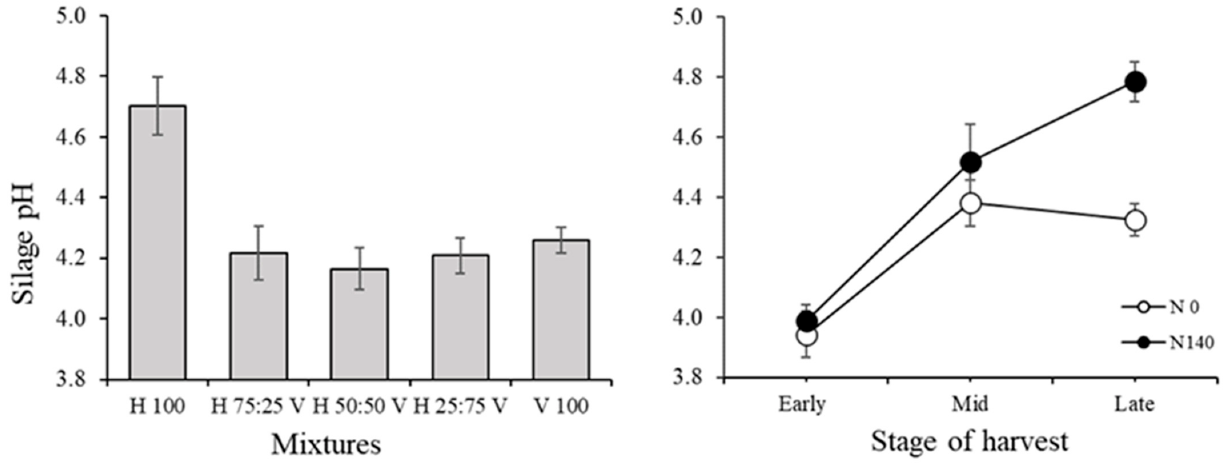
Figure 8. Silage pH as affected by MX ( left ) mean effect and SH × NF interaction ( right ; values refer to the treatments with N fertilization). On the left, values are LSmeans across all treatments along with standard error estimate of the LSmeans since the design was unbalanced between the faba bean crop ( n = 9) compared to the mixtures and the barley crops ( n = 18). On the right, only data of the barley-containing treatments were used. Each point represents the arithmetic mean ( n = 24) and its computed standard error.